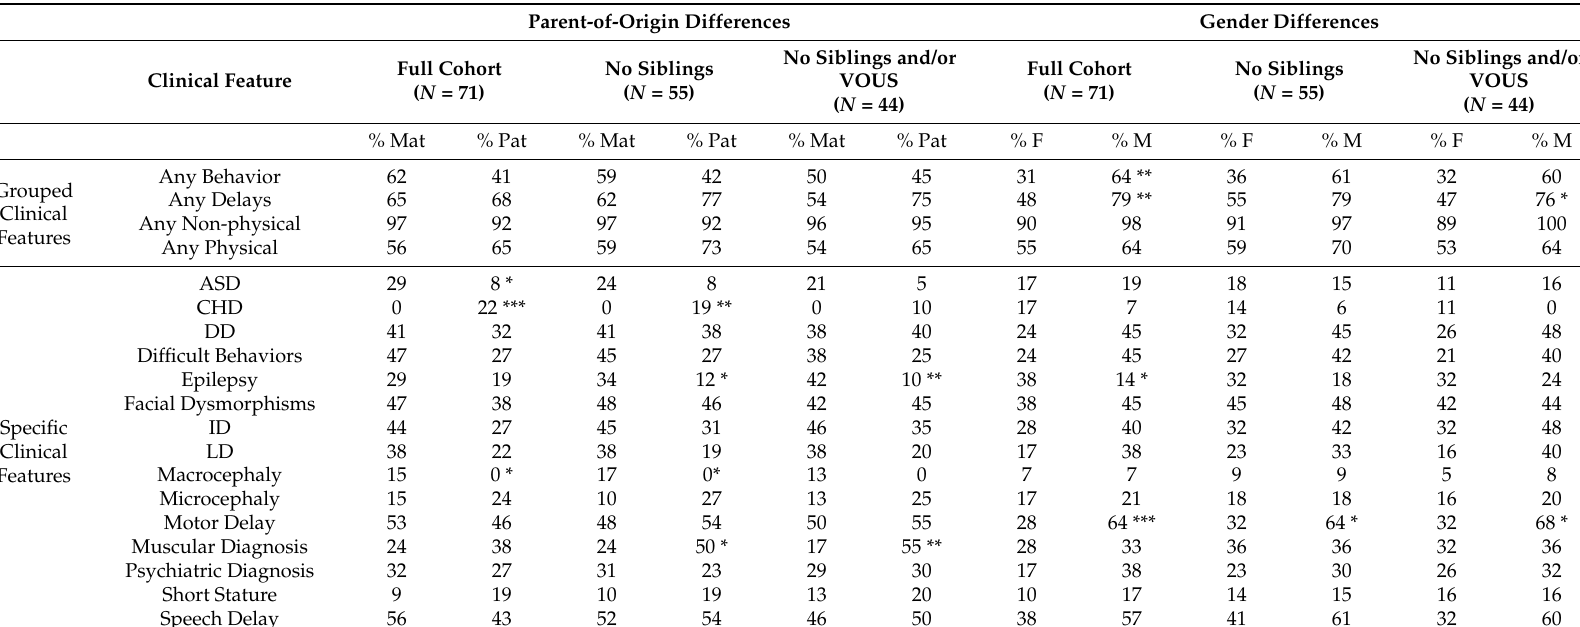
Table 4. Differences in clinical features in the proband by parental origin and gender of the 15q11.2 BP1-BP2